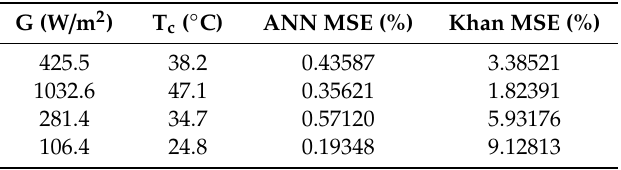
Table 3. The MSE between the measured and the predicted data for the ANN method and Khan’s analytical